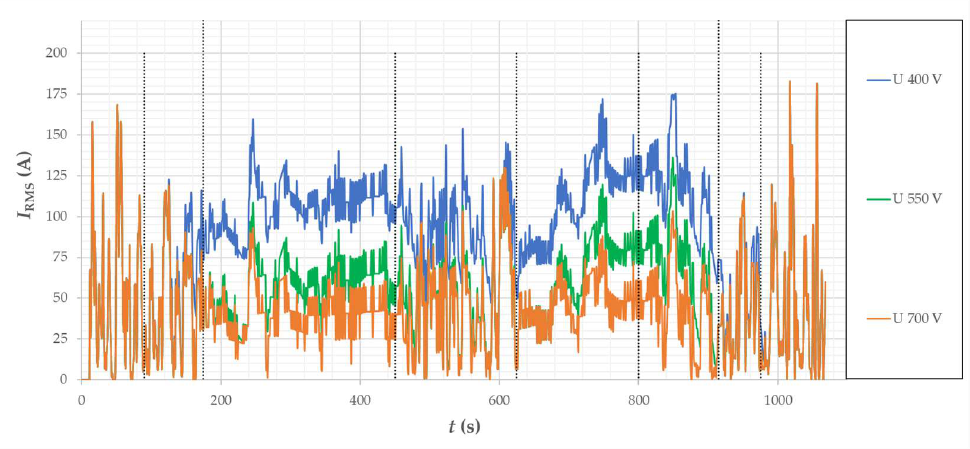
Figure 32. Calculated I RMS supply current waveforms of the motor for the considered vehicle in the Artemis Motorway150 cycle.